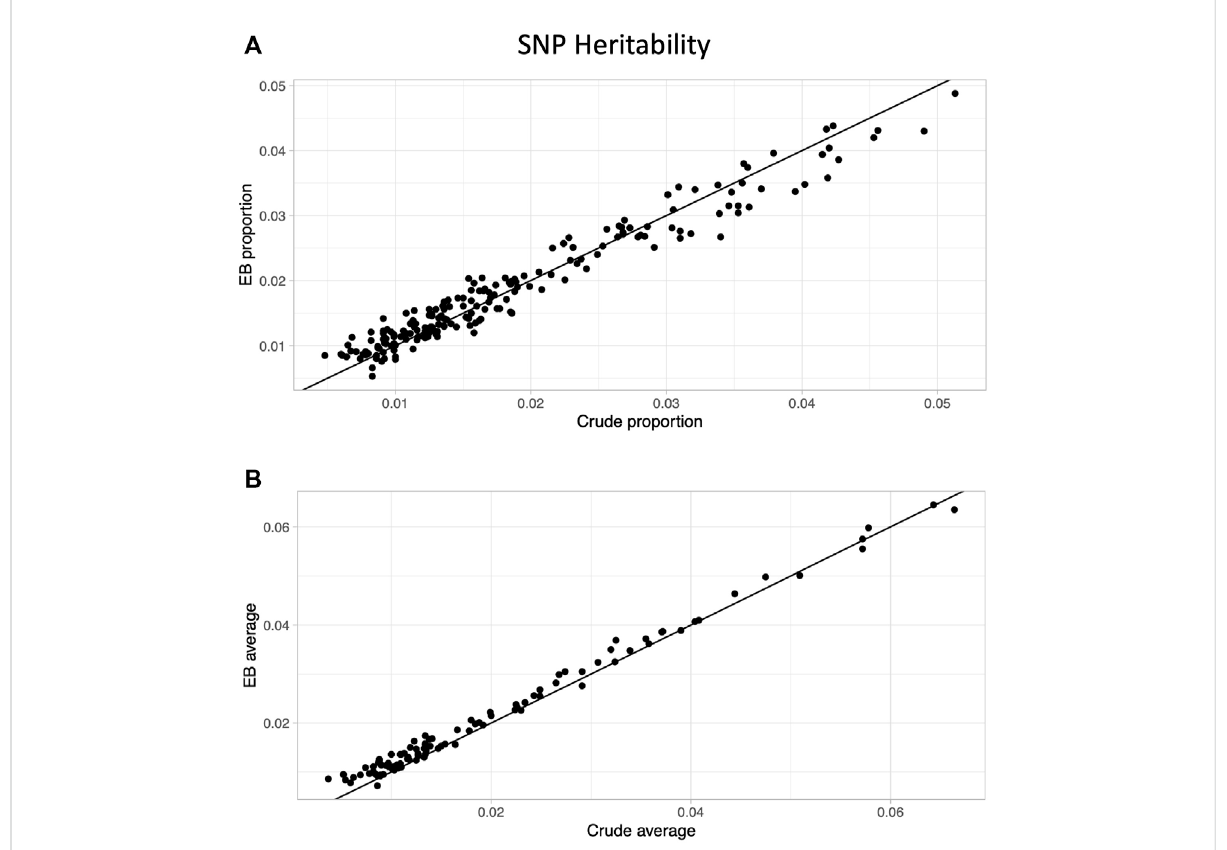
FIGURE 2 Heritability comparison between crude and Empirical Bayes approaches. Scatter plots of SNP heritability estimates comparing crude ( x -axis) and Empirical Bayes ( y -axis) for proportion phenotypes (A) and average phenotypes (B) . The black line is the line of